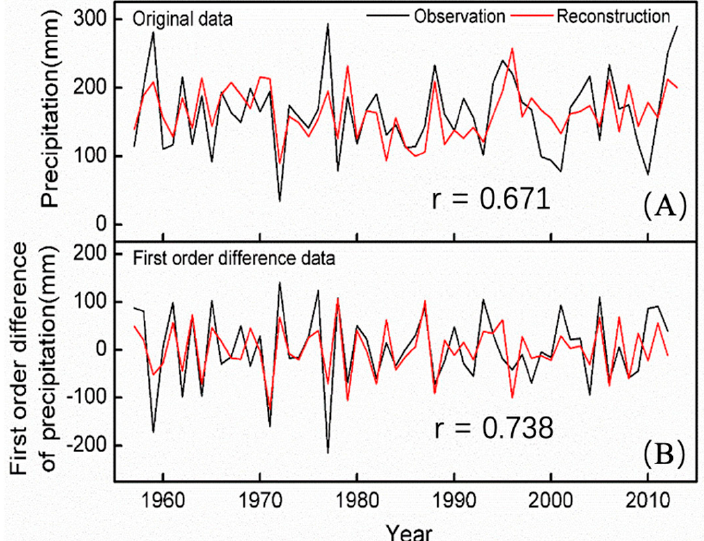
Figure 5. Comparison between the observed and the reconstructed P J-J (1957–2013 AD). ( A ) The original series. ( B ) The first order difference series.